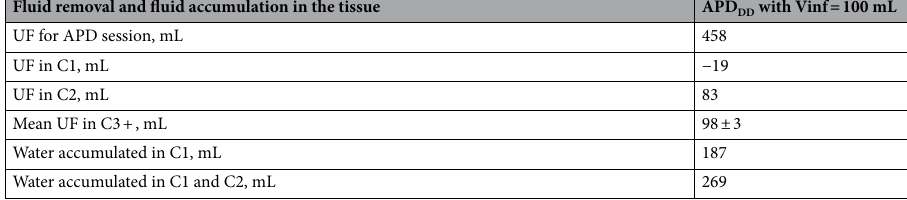
Table 5. Volumes of water removal predicted by the distributed model: net UF for the whole APD session, first (C1) and second (C2) APD cycle and mean ± SD net UF in consecutive cycles (C3 + ), and water accumulation in the peritoneal tissue during the first cycle (C1) and during first two cycles (C1 plus C2) for a typical patient undergoing APD with a dry day regime (APD DD ) with infusion of 100 mL of glucose 1.36% during the day to prevent pain.